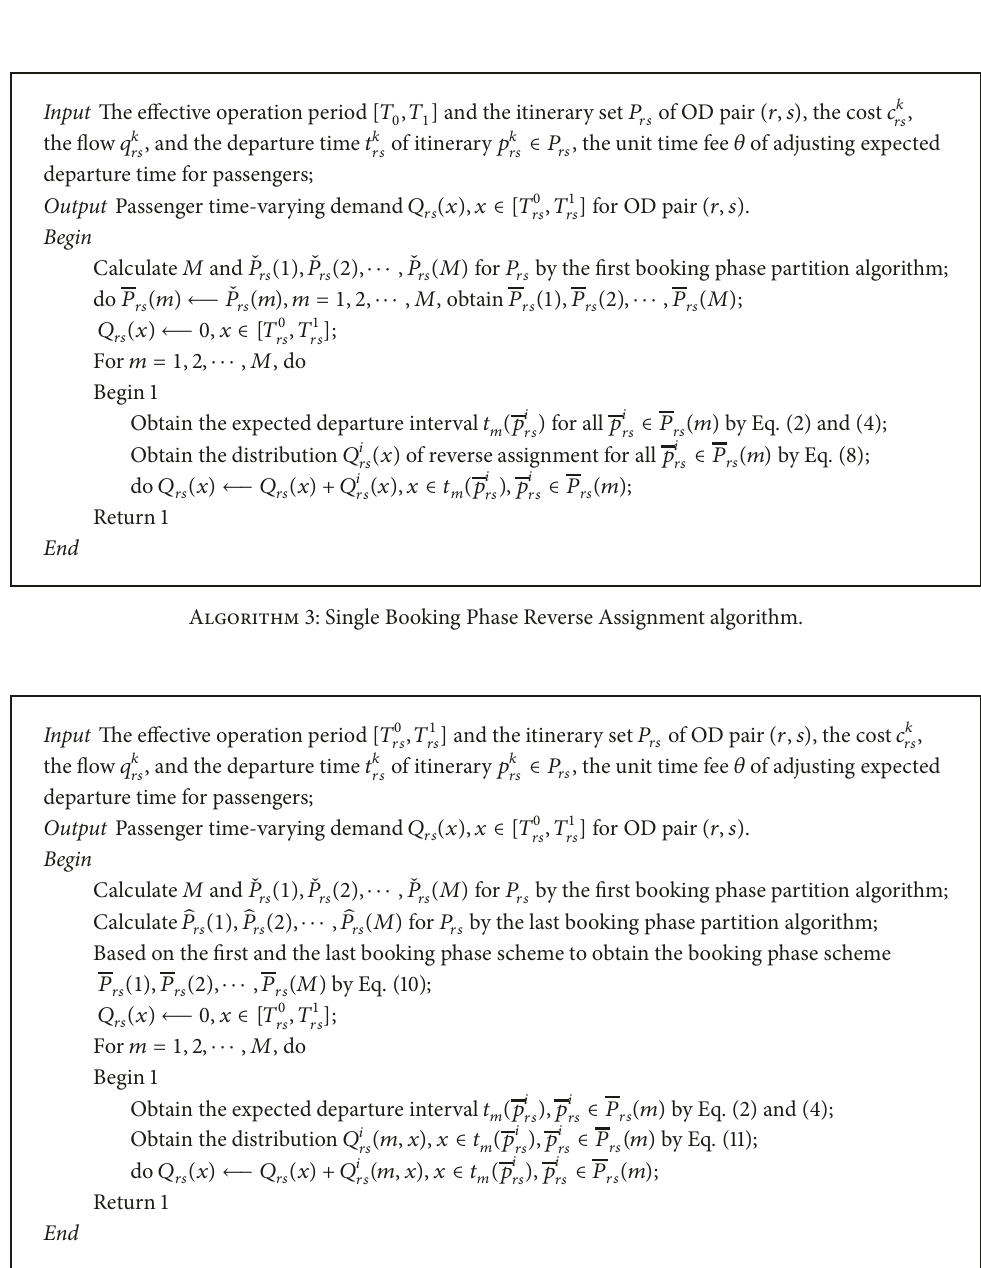
Algorithm 4: Multiple Booking Phases Reverse Assignment